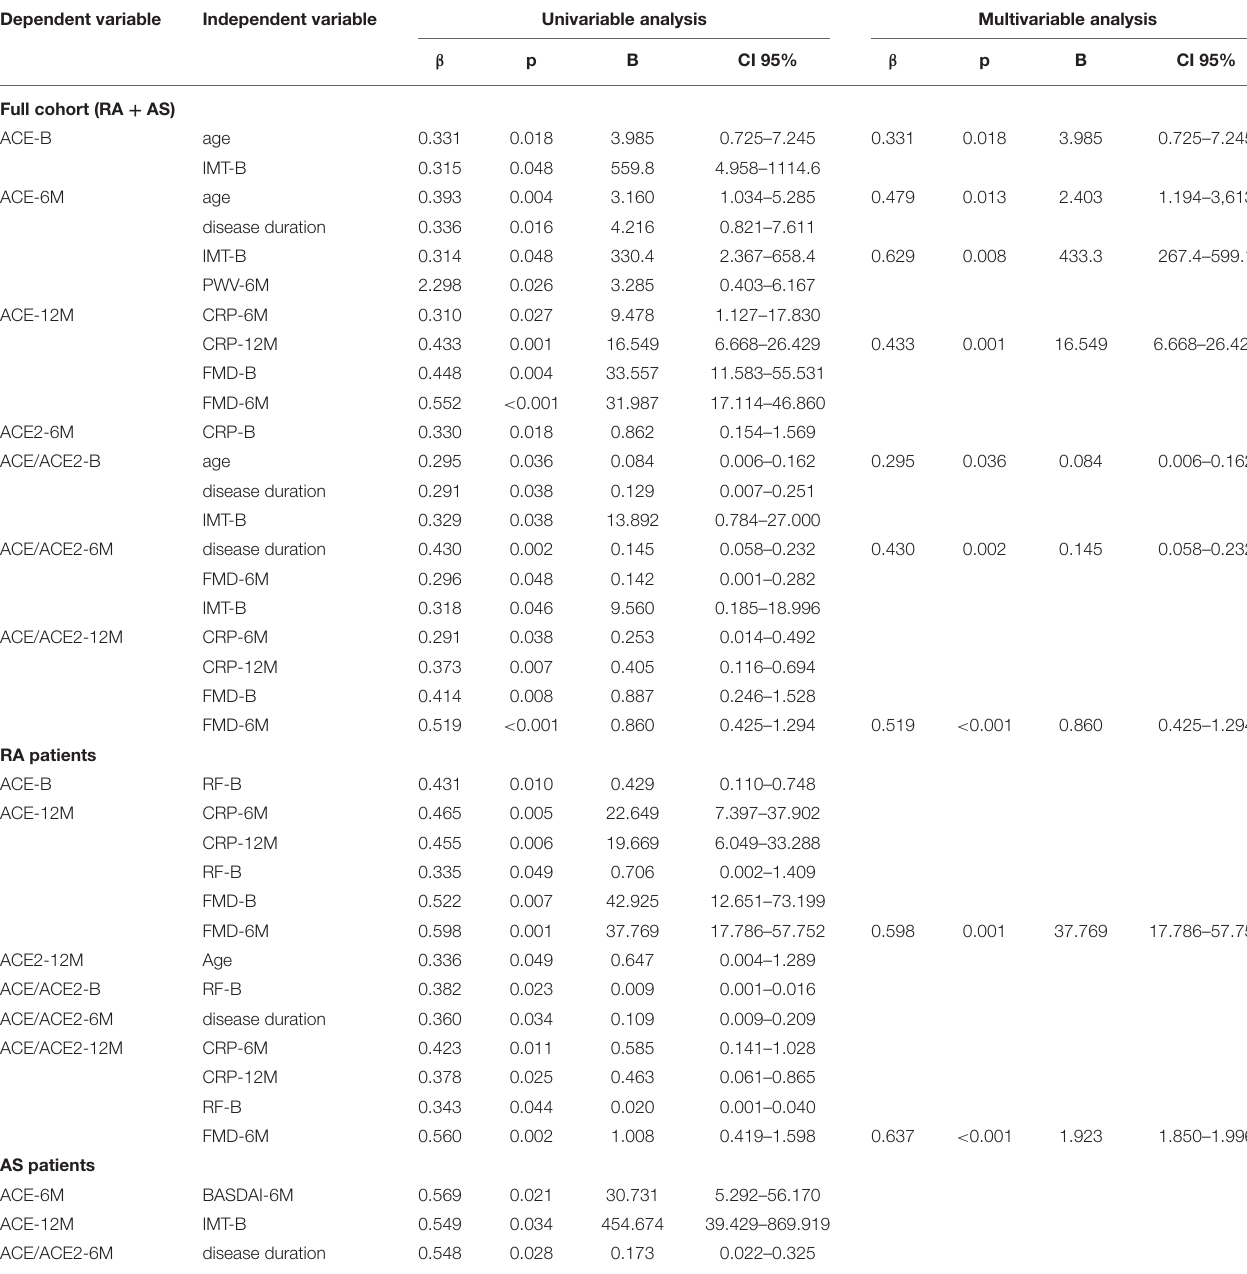
TABLE 2 | Univariable and multivariable regression analysis of ACE and